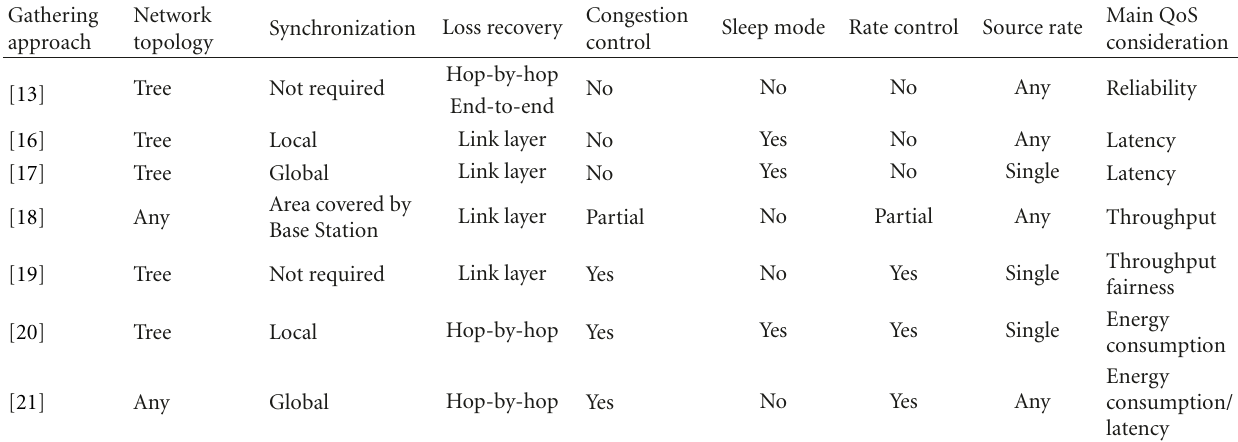
Table 1: Di ff erent data gathering